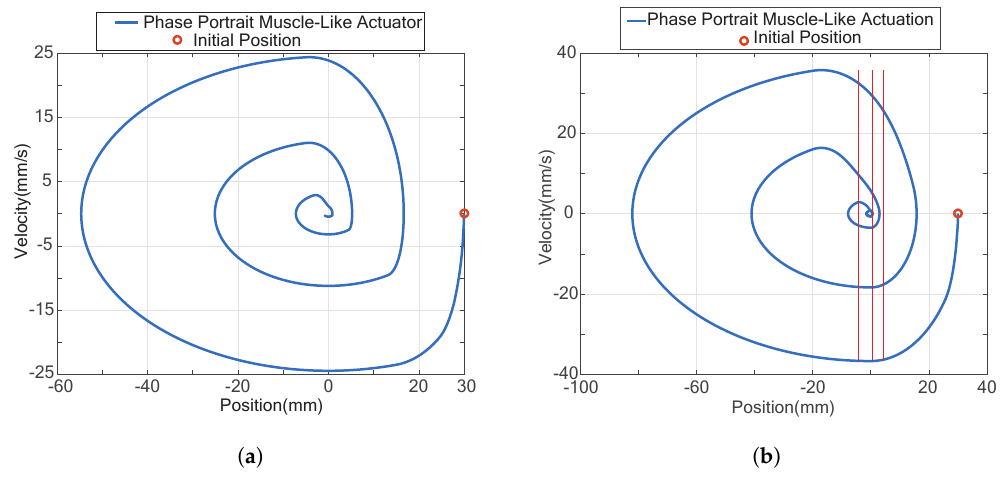
Figure 10. Observer control phase portraits with two different discrete quantization methods: ( a ) quantization Method I; and ( b ) quantization Method II.